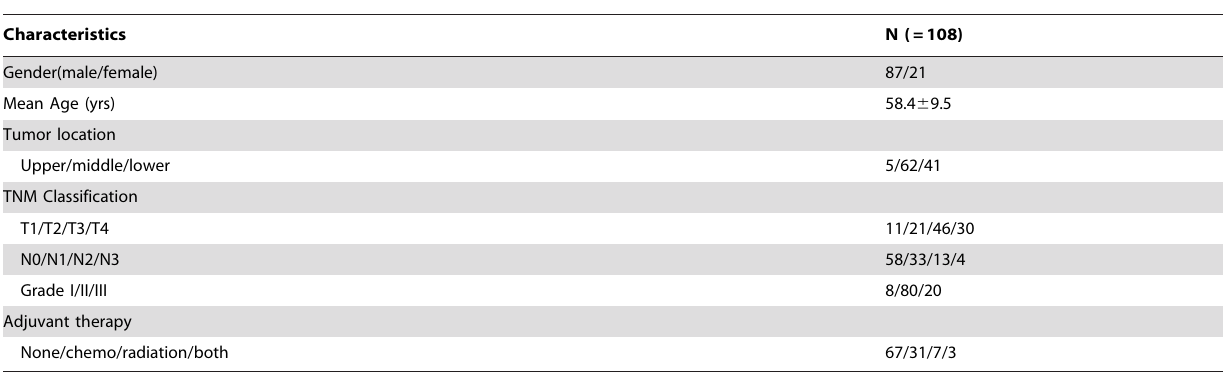
Table 1. Patient characteristics.